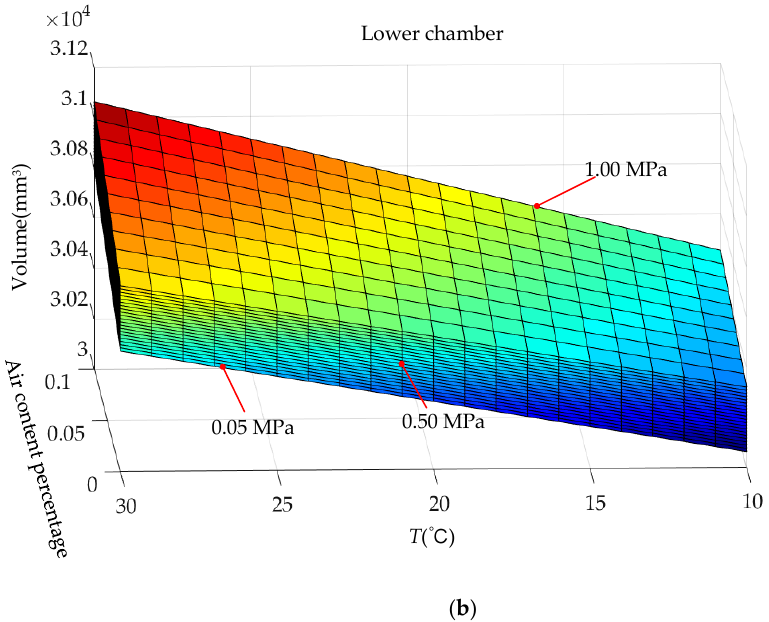
Figure 4. Variation of volume of upper and lower chambers with temperature and air content. ( a ) Volume of upper chamber. ( b ) Volume of lower chamber.